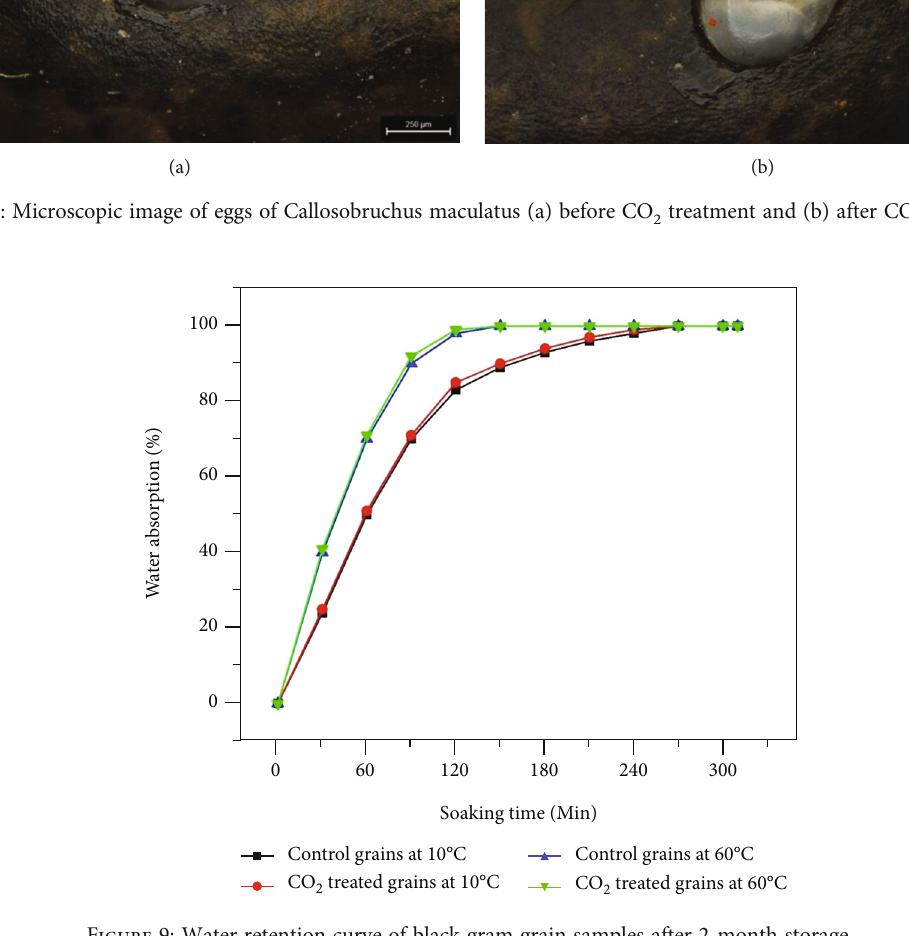
Figure 9: Water retention curve of black gram grain samples after 2-month